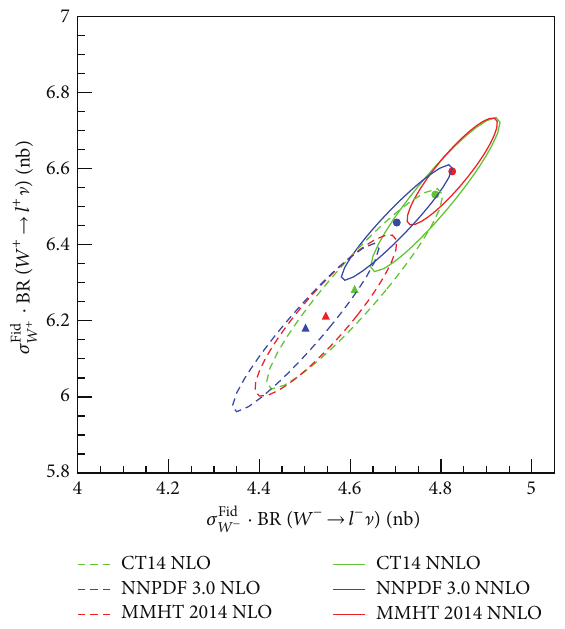
Figure 4: Predicted fiducial cross sections times leptonic branching ratios at √𝑠 = 13 TeV, 𝜎 𝑊 + versus 𝜎 𝑊 − . The ellipses illustrate the total uncertainties.